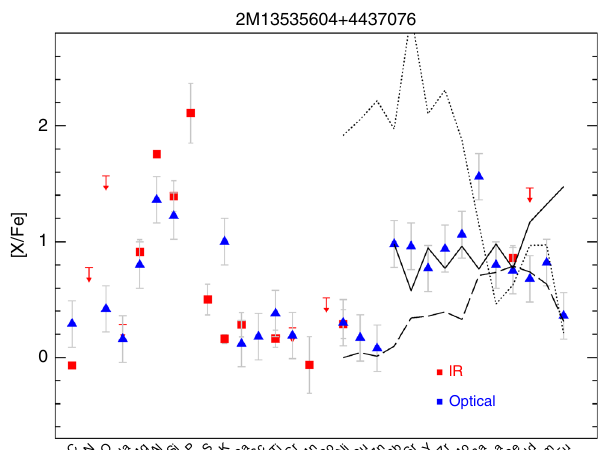
Fig. 8 Chemical abundance pattern of the P-rich star 2M13535604 + 4437076. Blue triangles and red squares are the abundances values obtained from the optical and near-IR spectra, respectively, where the arrows indicate upper limits. Error bars show the measurement uncertainties such as shown in Supplementary Table 3. The solid black line shows the solar r-process pattern scaled to match the Ce abundance from ref. 29 , while the long-dashed line shows an s-process theoretical pattern for a 1.5 M ⊙ star at [Fe/H] = − 1.0 diluted by 50% to match the Ce abundance from ref. 30 (a model as close as possible to the P-rich star chemical pattern, as found in literature) and the dotted line illustrate the weak s-process such as obtained by a model of a 20 M ⊙ star with Z = 0.001 without dilution from ref. 27